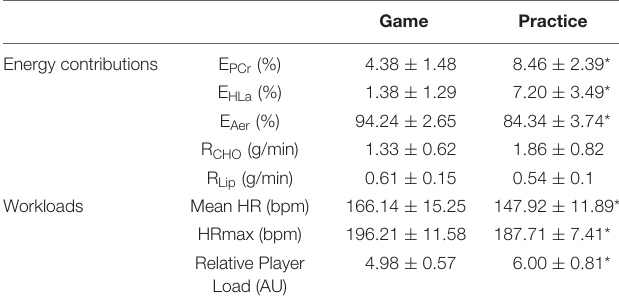
TABLE 4 | Differences of energy contributions and workloads between games and